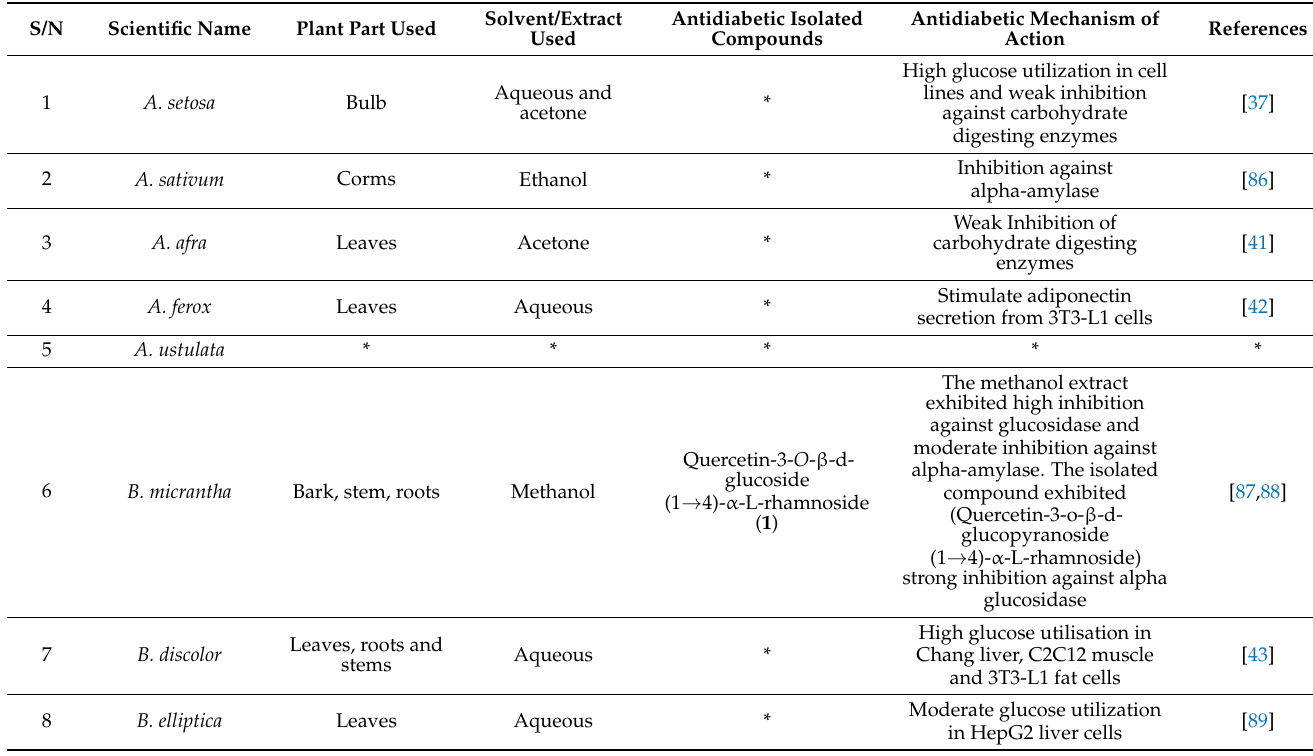
Table 2. Plant used traditionally in the Eastern Cape with reported antidiabetic